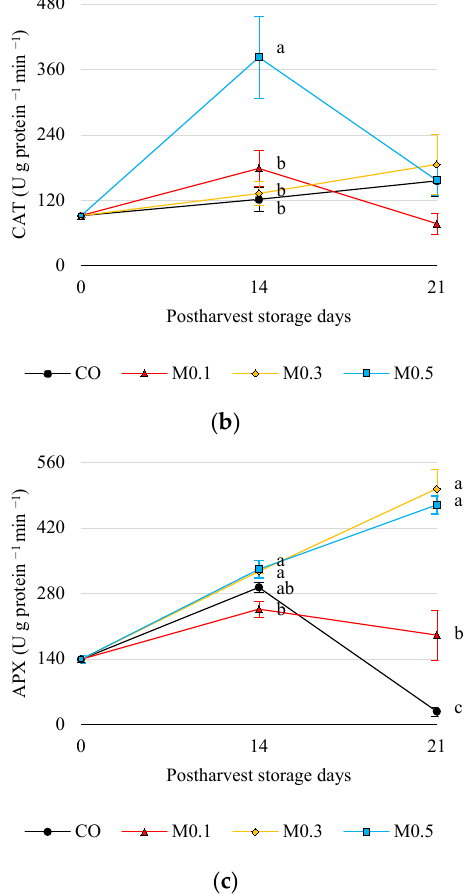
Figure 5. Enzymatic antioxidant activities of ‘Samba’ cherries in relation to treatments and storage time. ( a ) Peroxidase antioxidant activity (POD) (U g protein − 1 min − 1 ), ( b ) Catalase antioxidant activity (CAT) (U g protein − 1 min − 1 ), ( c ) Ascorbate peroxidase antioxidant activity (APX) (U g protein − 1 min − 1 ). Mean values ± SE. By storage time, le tt ers indicate signi fi cant di ff erences between treatments at p ≤ 0.05 (Tukey’s test).